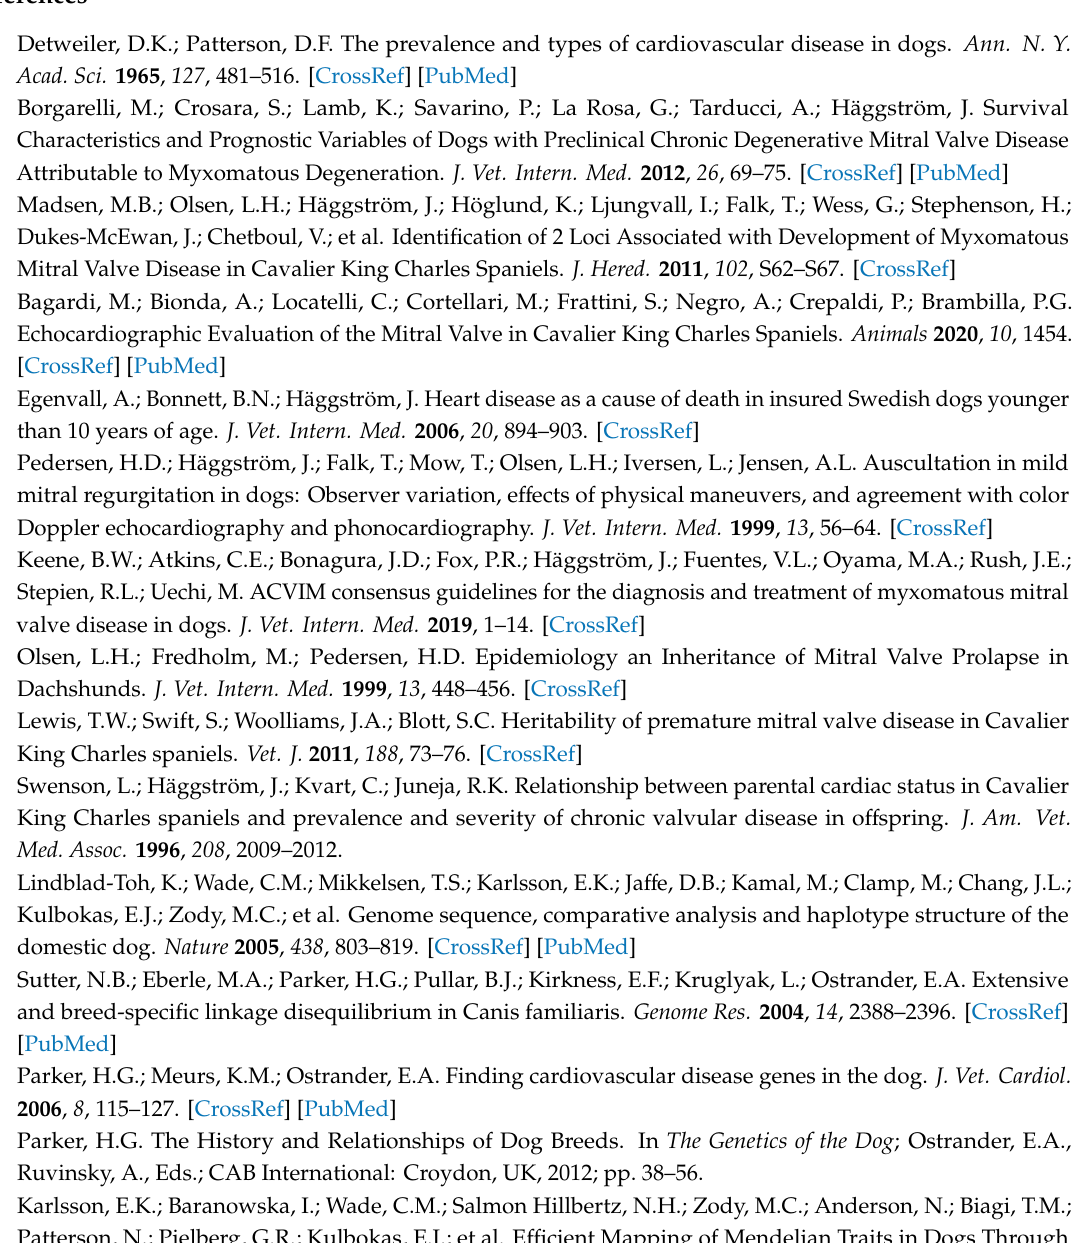
Table S1. Proportion of cases and controls showing a run of homozygosity in regions flanking selected